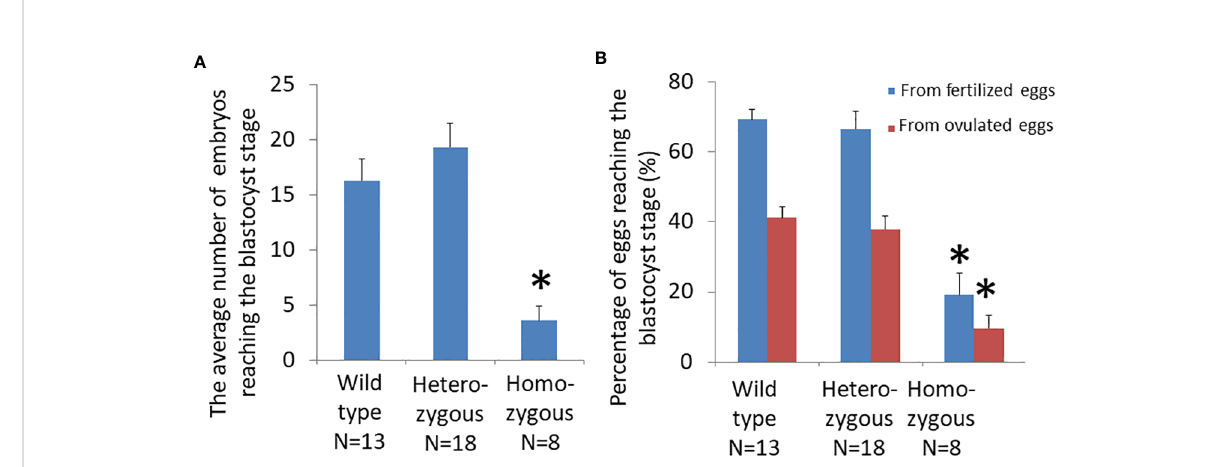
FIGURE 4 Effects of oocyte-speci fi c Adm2 disruption on oocyte quality. (A) The number of blastocysts on E3.5 day from wild-type ( Adm2 ++ /Zp3 -Cre, N=13), heterozygous ( Adm2 +/- /Zp3 -Cre, N=18), and homozygous ( Adm2 -/- /Zp3 -Cre, N=8) mice. (B) The percentage of ovulated eggs and fertilized eggs that developed to the blastocyst stage following culture in vitro for 48 hr (mean ± SEM). *, signi fi cantly different from the wild- type or heterozygous groups at p <